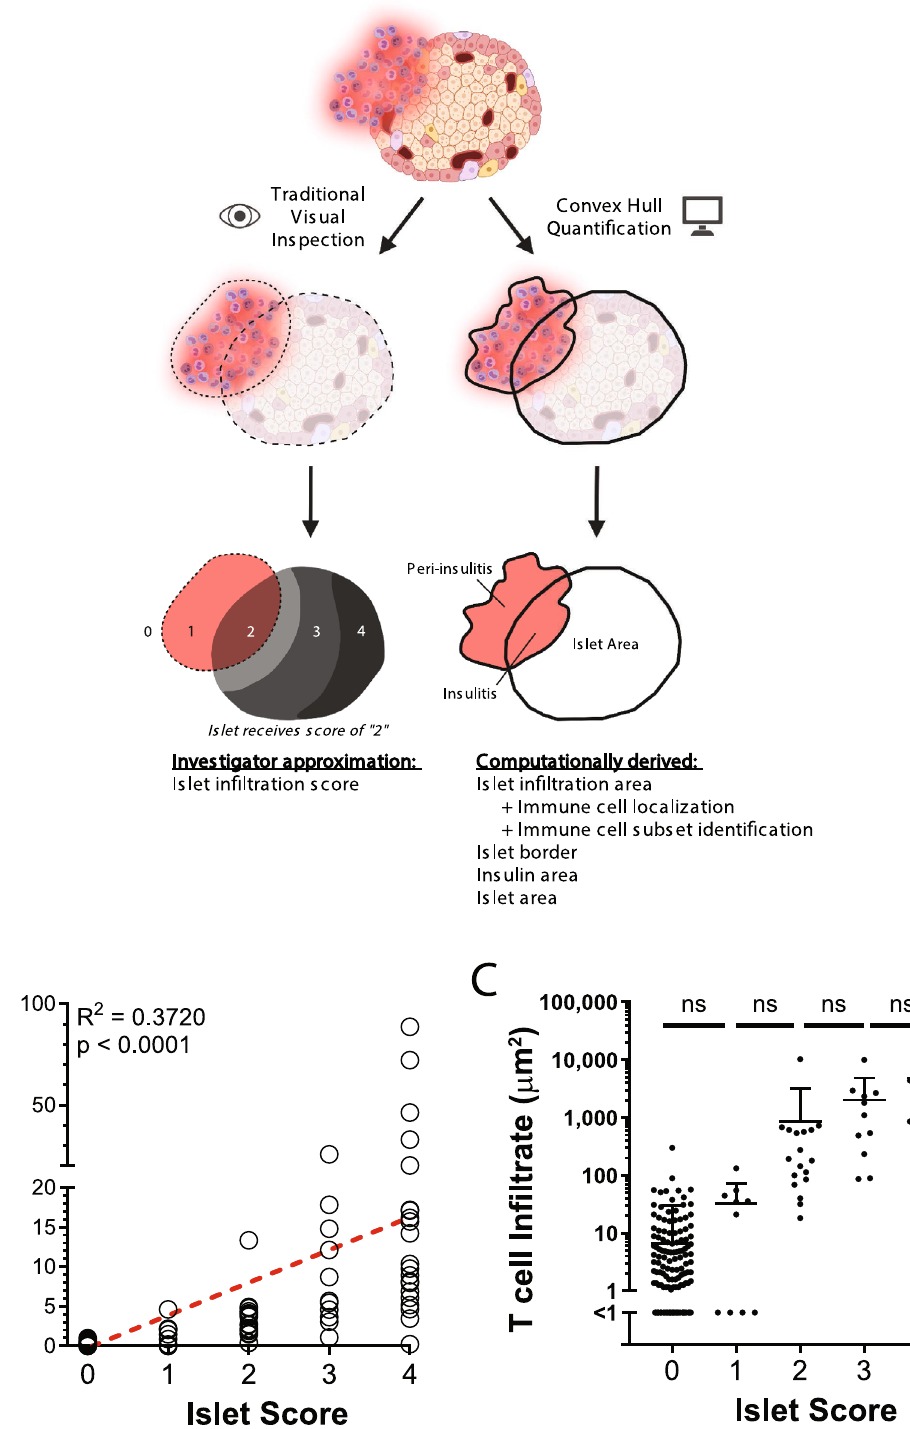
Figure 5. Quantitative assessment of islet infiltration detects variability that traditional qualitative islet scoring approaches fail to identify. ( A ) Diagram comparing assessment of islet infiltration using the traditional visual inspection method (left) vs. the convex hull quantification method (right). The traditional approach generates an approximate islet infiltration score (“2” for the depicted islet) while the convex hull approach provides multiple computationally derived quantifiable metrics. ( B , C ) Individual islet images from 4-week-old (n = 93), 13-week-old non-diabetic (n = 71) and 17-week-old diabetic NOD mice (n = 23) and 11-week-old NOD.RAG1. KO (n = 55) mice were pooled within each group (n = 3/group) and analyzed with both our quantitative methodology and a traditional qualitative islet scoring approach performed by a blinded analyzer. ( B ) Linear regression between quantified proportion of individual islet areas occupied by T cells and traditional qualitative islet scores. Dotted red line on the linear regression plot represents the line of best fit. ( C ) Qualitative islet scores for each islet plotted against their corresponding quantified T cell infiltrate areas. Islet scoring: 0—no insulitis, 1—peri-insulitis, 2—< 25% of islet mass infiltrated, 3—< 75% of islet mass infiltrated, 4—> 75% of islet mass infiltrated. Kruskal–Wallace test with post-hoc Dunn’s multiple comparison test was performed to determine statistical significance. ns, not significant. Data are pooled of three independent